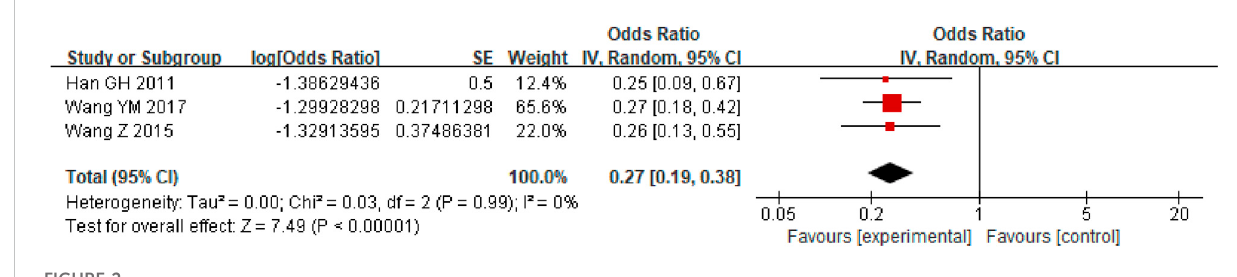
FIGURE 2 The occurrence of stent dysfunction.